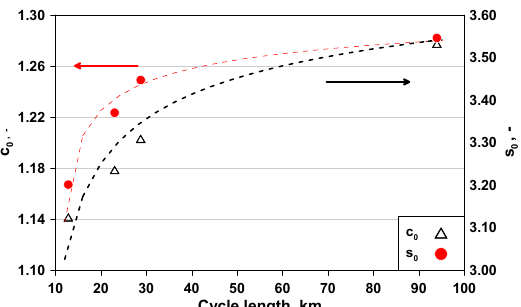
Figure 11. Parametric analysis of c 0 on SoC evolution along WLTC; comparison with SoC*.